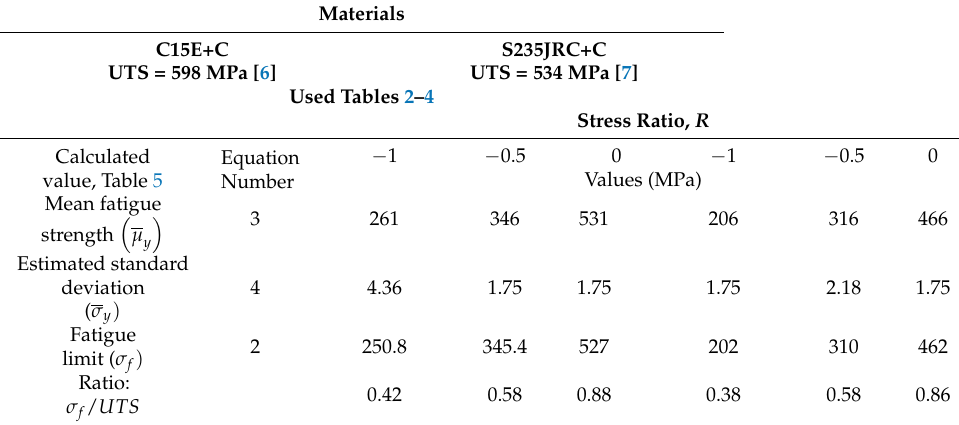
Table 6. Calculated values based on fatigue test results and Table